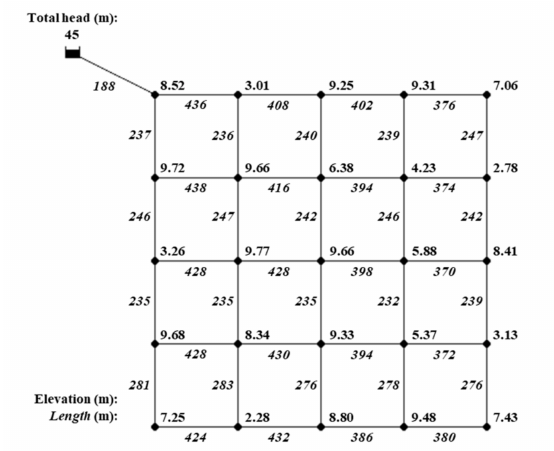
Figure 2. Configuration of application grid network (P-41).